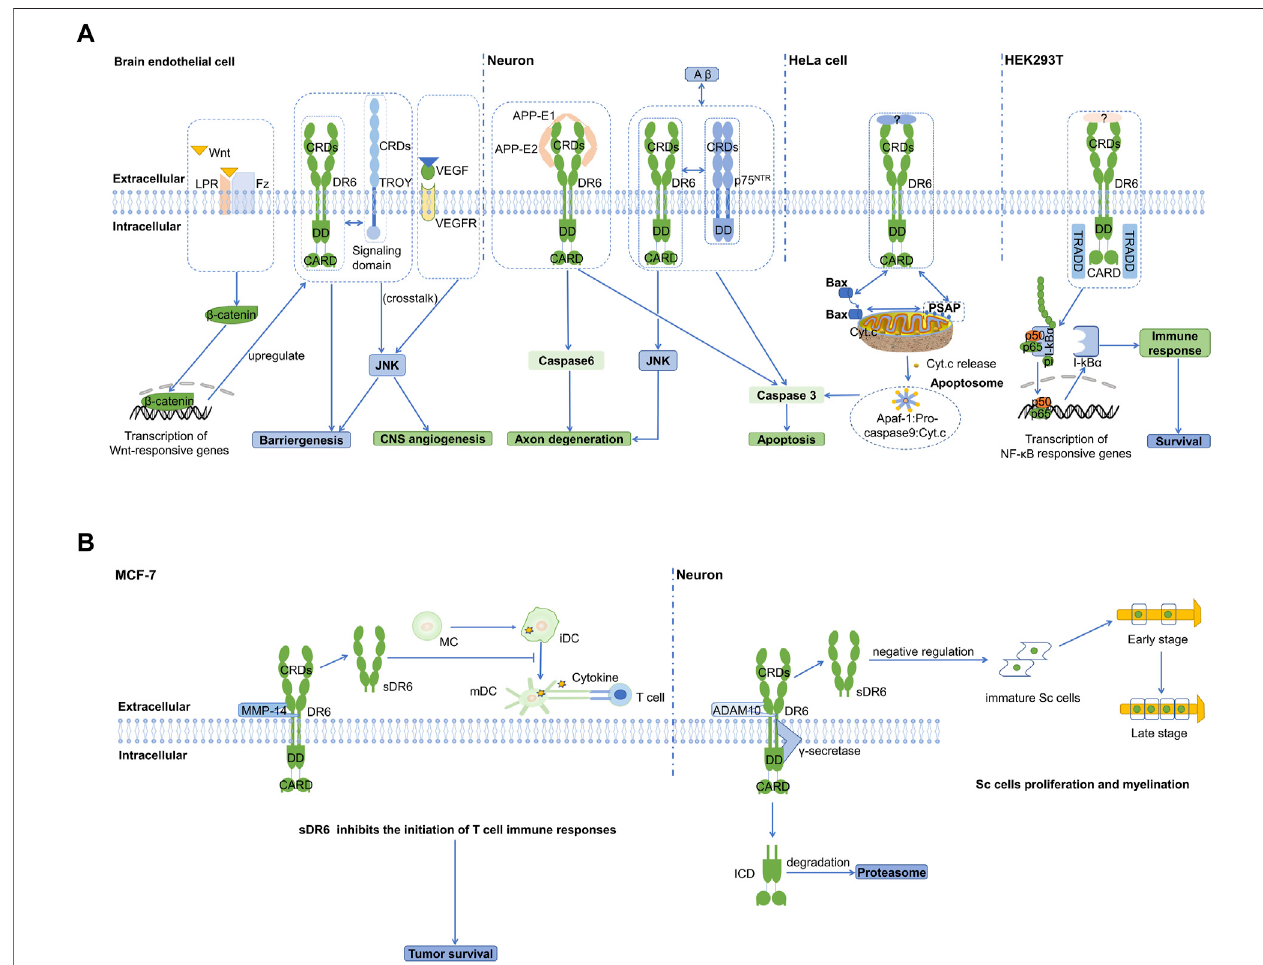
FIGURE 3 | Cartoon models of DR6 signaling (A) DR6-mediated intracellular signaling pathways are showed in four different cells, brain endothelial cell, neurons, HeLa,andHEK293T.Inbrainendothelialcell,DR6andTROYcomplexisinvolvedinangiogenesisandBBBformation.TheyareregulatedbyWnt/ β -cateninsignalingand engage in crosstalk with the VEGF/VEGFR2 signaling pathway. In neuron cells, DR6 can interact with APP or p75 NTR to promote neuronal apoptosis and axonal degeneration. In HeLa cells, DR6 can promote mitochondria-dependent apoptosis through membrane protein PSAP. In HEK293T, DR6 can induce NF-kB pathway and promote cell survival through adaptor protein TRADD. (B) Extracellular signaling pathway of sDR6. In MCF-7 cancer cell line, cleavage of the extracellular region of DR6 by the metalloenzyme MMP-14 leads to the formation of sDR6. This soluble protein can hinder the differentiation of monocytes into immature dendritic cells,therebyinhibitingthebody ’ simmuneresponse.Inneurons,sDR6producedbymetalloproteaseADAM10cleavagecantrans-actonSchwanncellsandinhibittheir proliferation and myelination in the PNS. The intracellular domain is released into the cytosol and rapidly degraded by